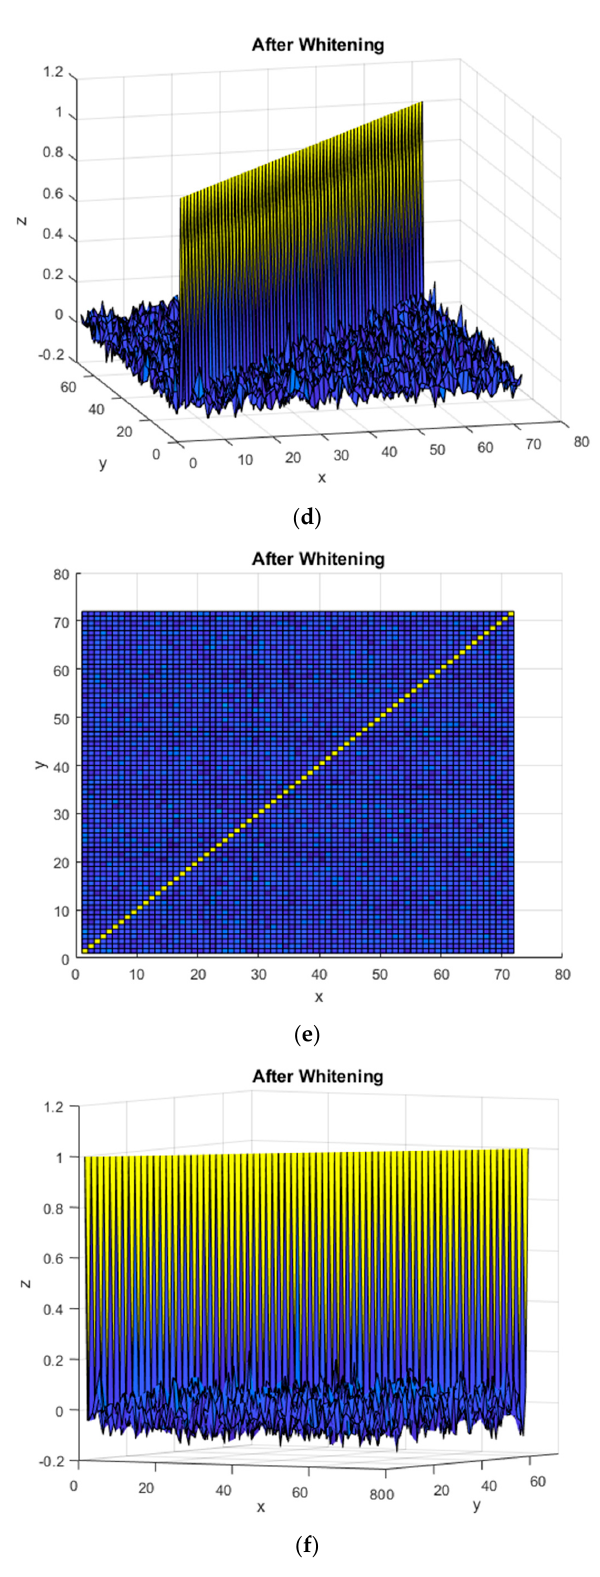
Figure 7. ( a , b ) Covariance matrix variances of C4D2a_2C for the first subject without BCICW method; ( c ) enlarged figure of ( a , b ); ( d , e ) covariance matrix variances of C4D2a_2C for the first subject without whitening method; ( f ) enlarged figure of ( d , e